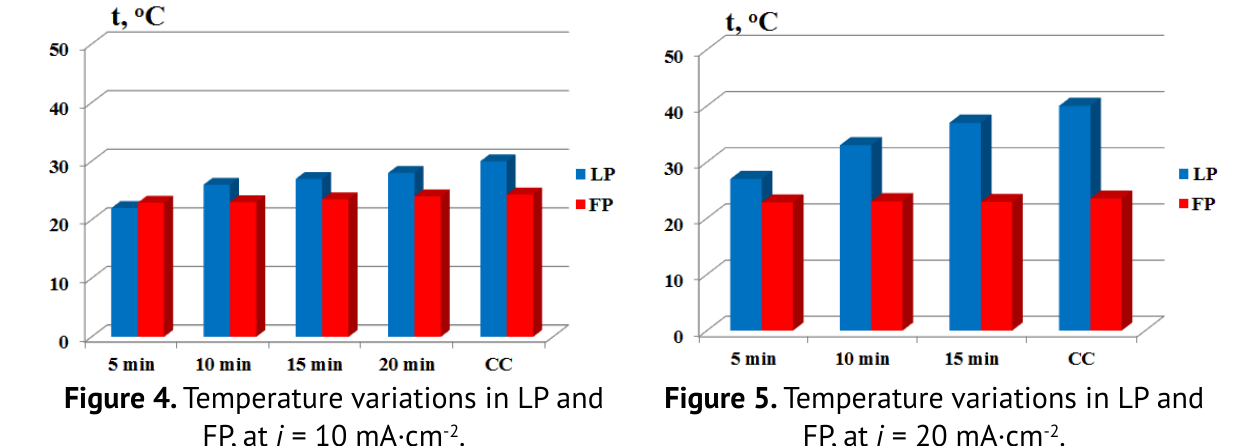
Figure 5. Temperature variations in LP and FP, at j = 20 mA·cm -2 .